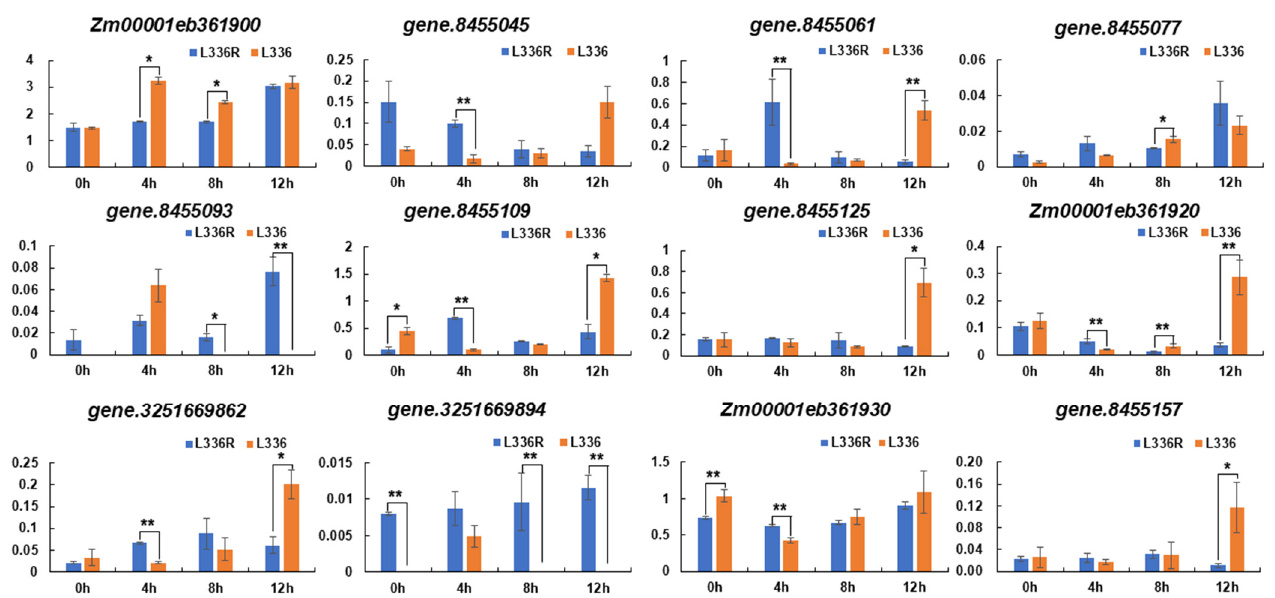
Figure 4. Transcript level evaluation of the candidate genes in the ZmGHT1 locus. Gene.3251669926 was excluded due to no transcript accumulation at any time points; * indicates p < 0.05 and ** indicates p < 0.01, respectively.